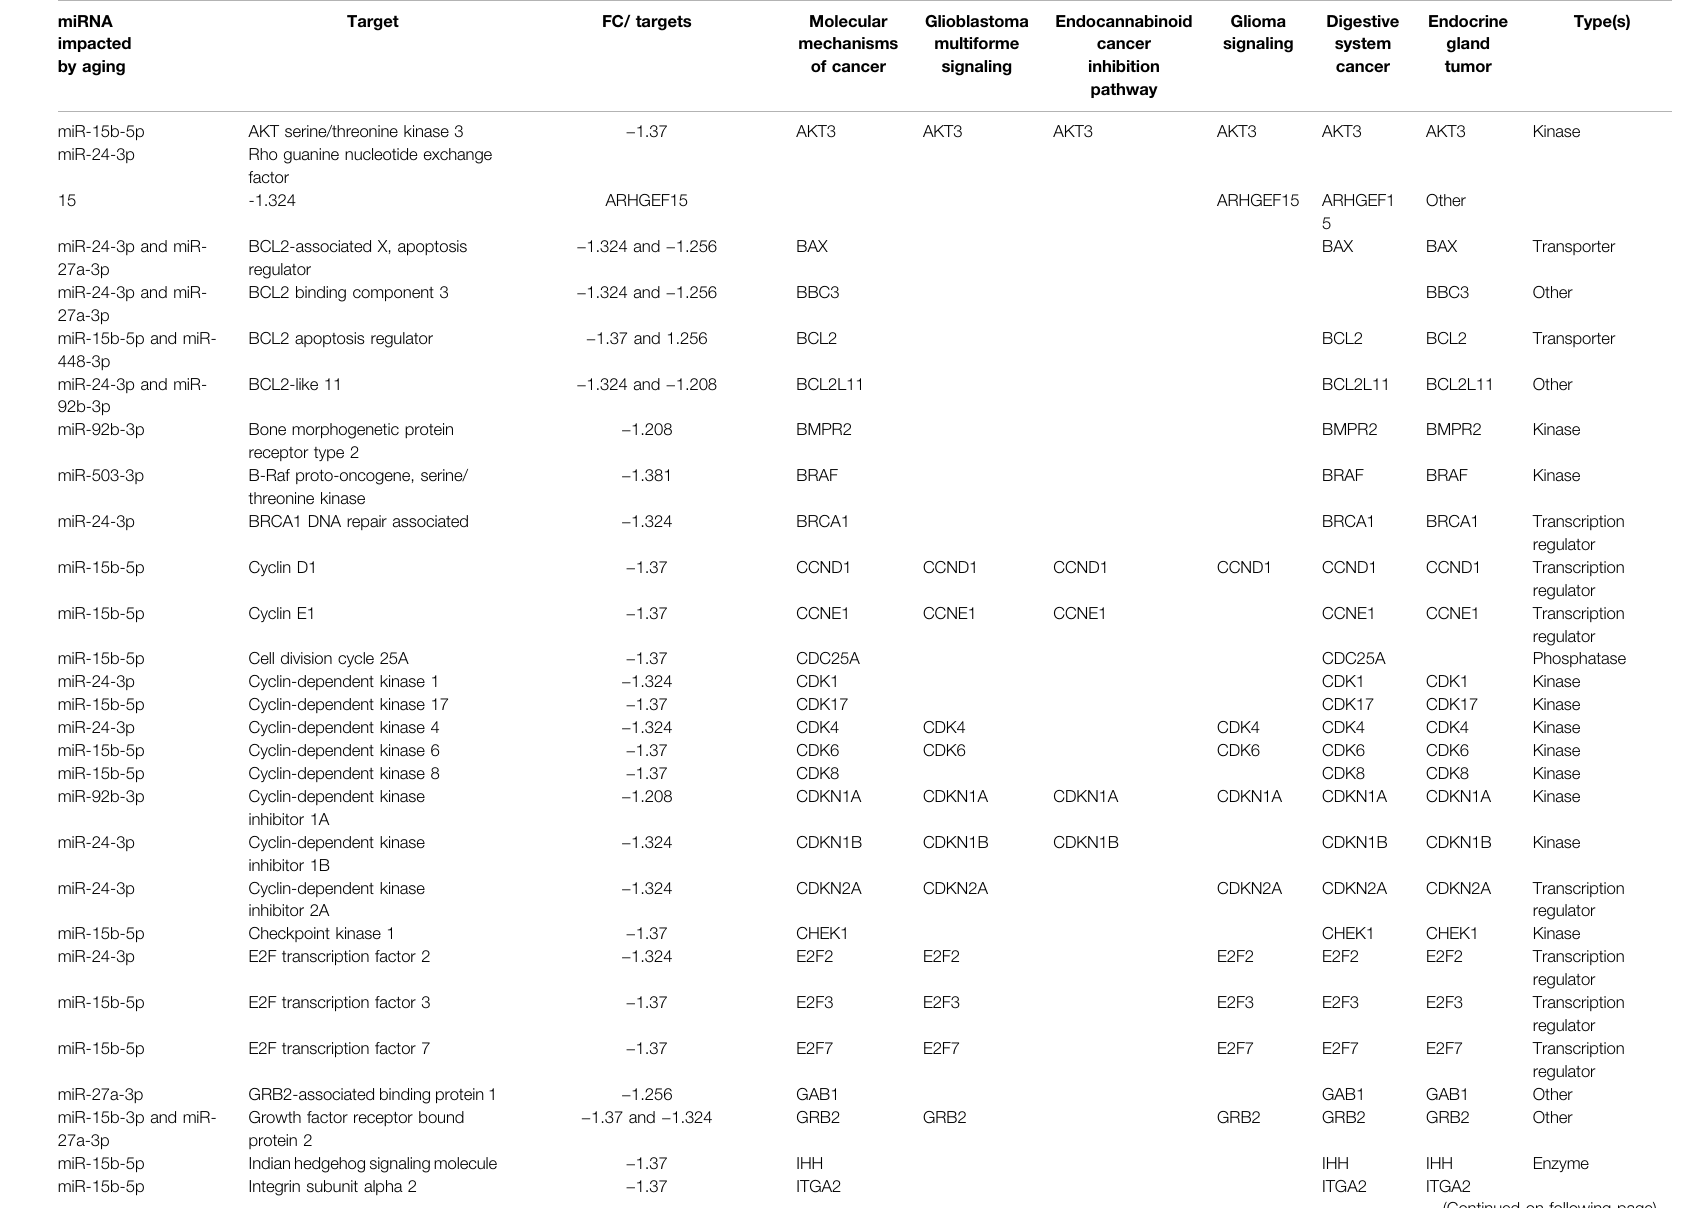
TABLE 4 | Similar and different predicted targets of different top “ canonical pathways ” and “ disease and functions ” categories related to cancer.